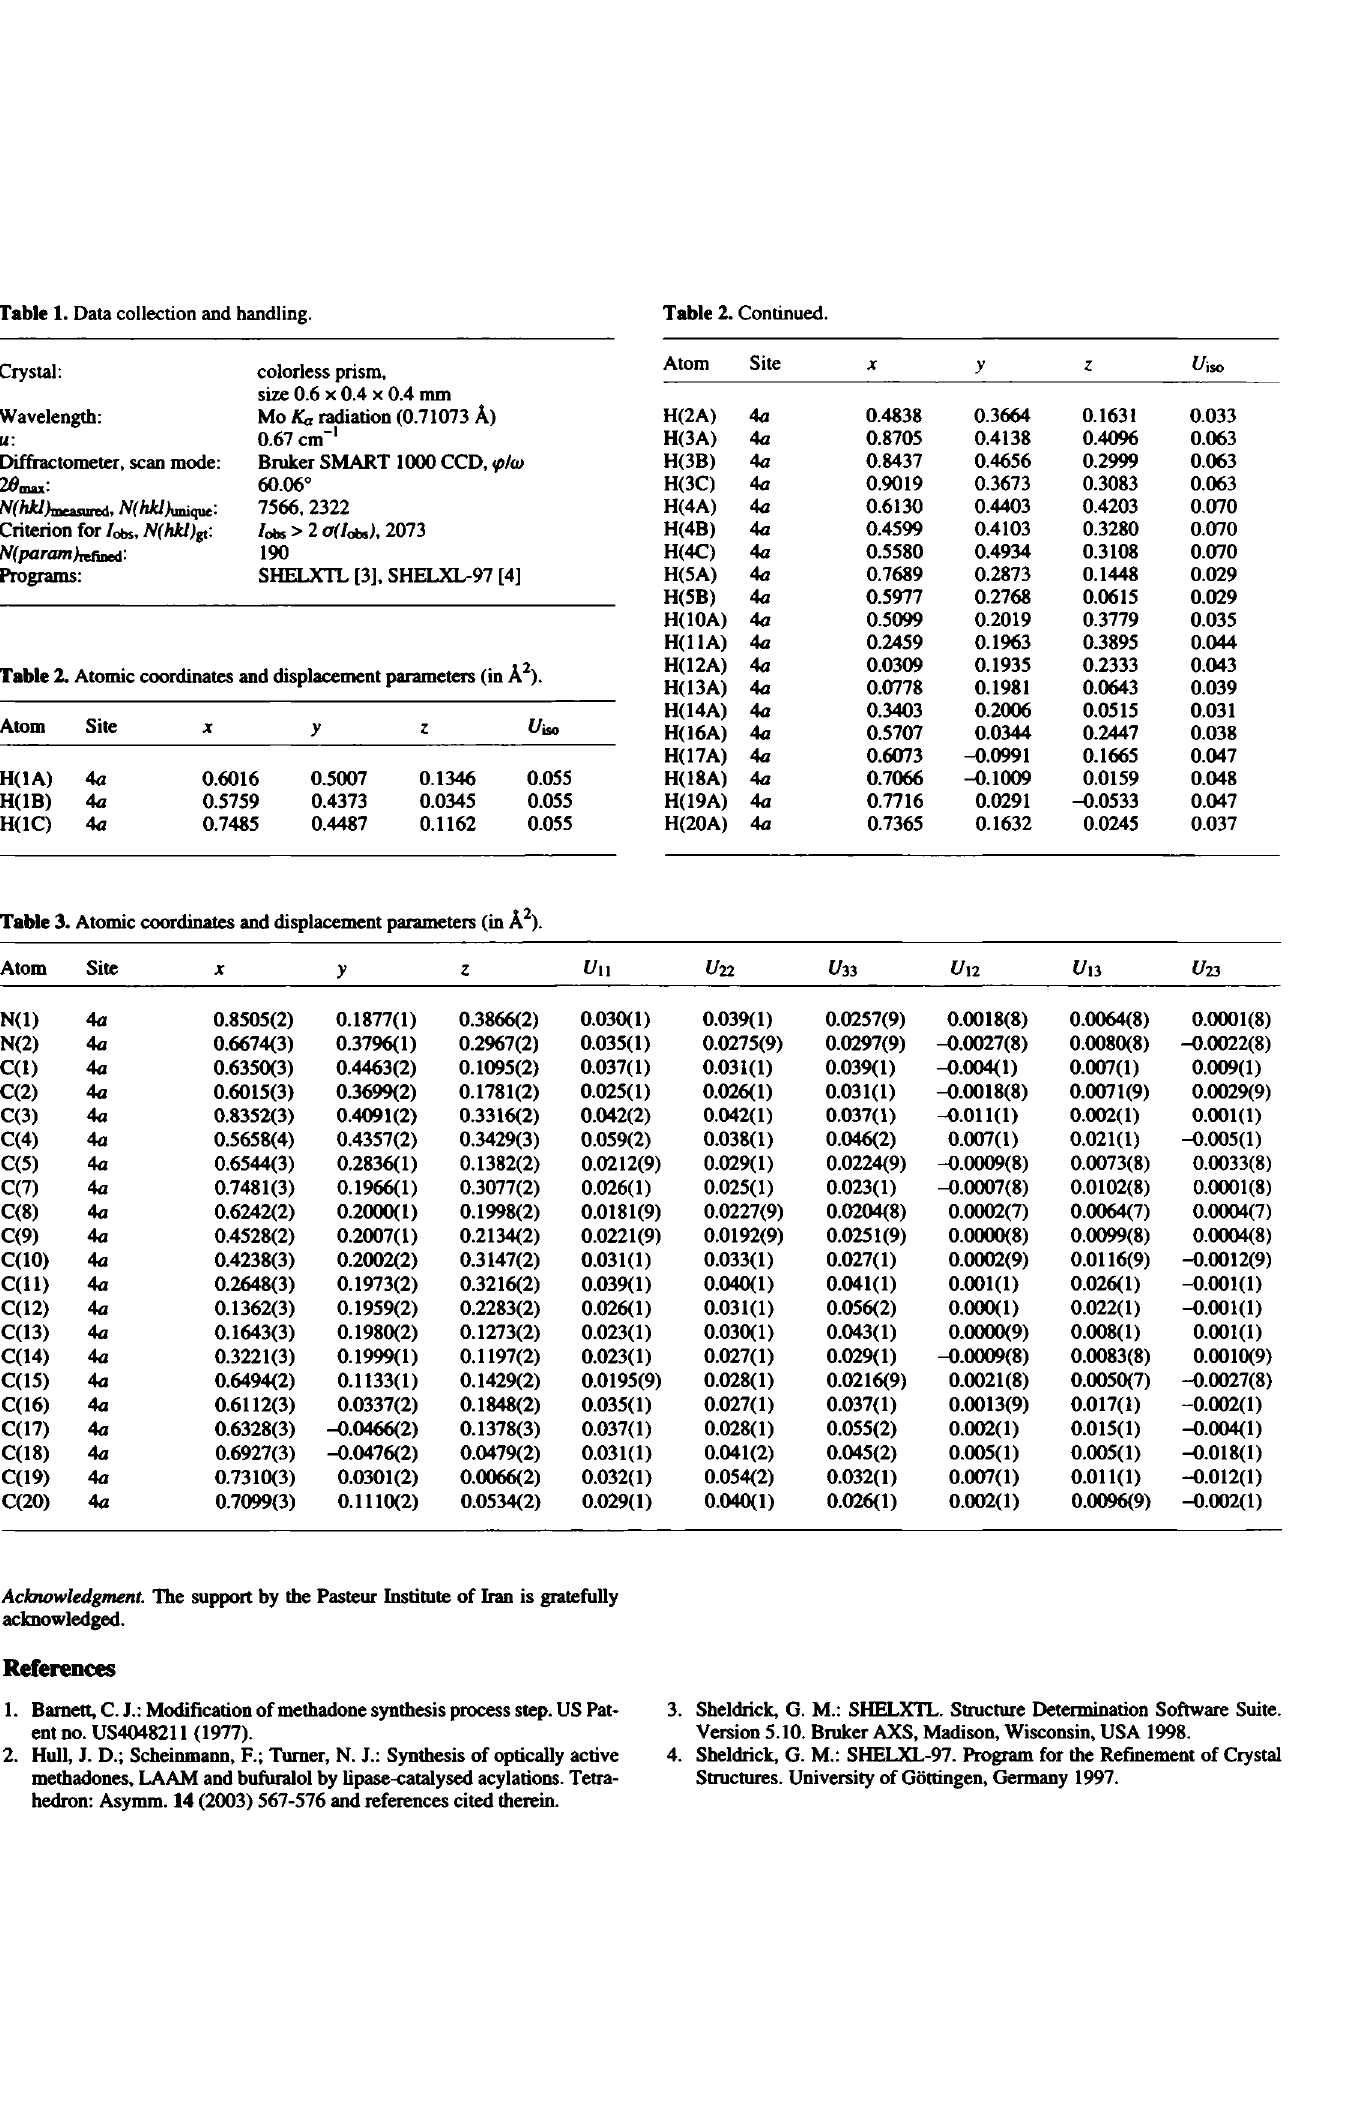
Table 2. Atomic coordinates and displacement parameters (in A 2 ).